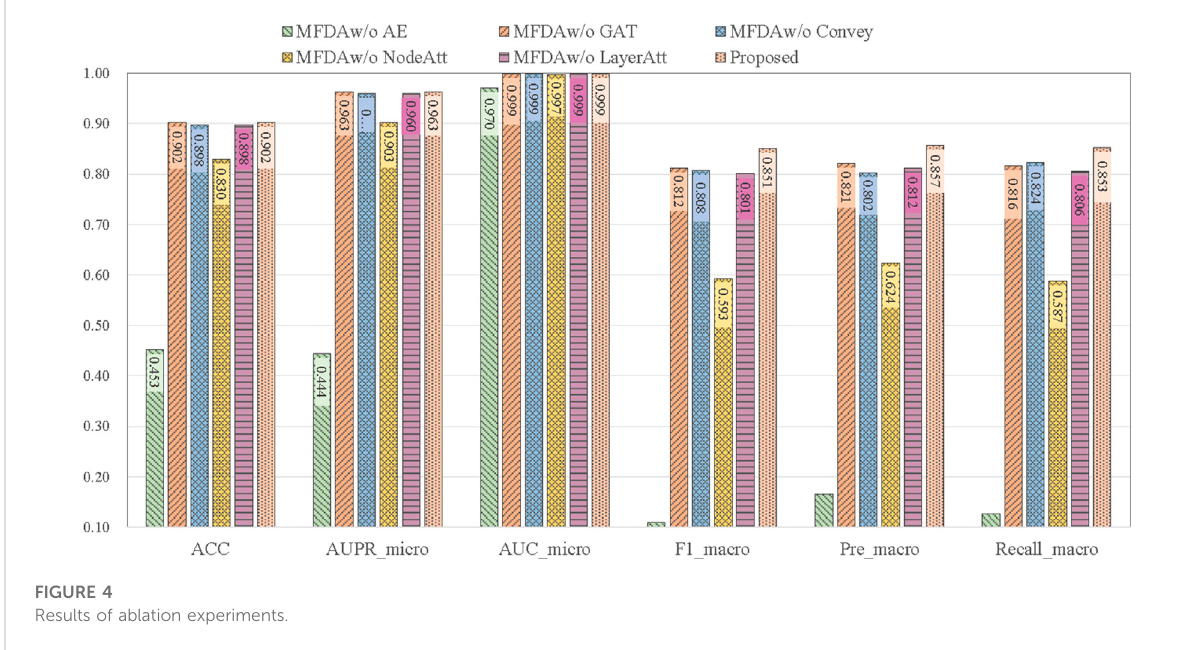
FIGURE 4 Results of ablation experiments.